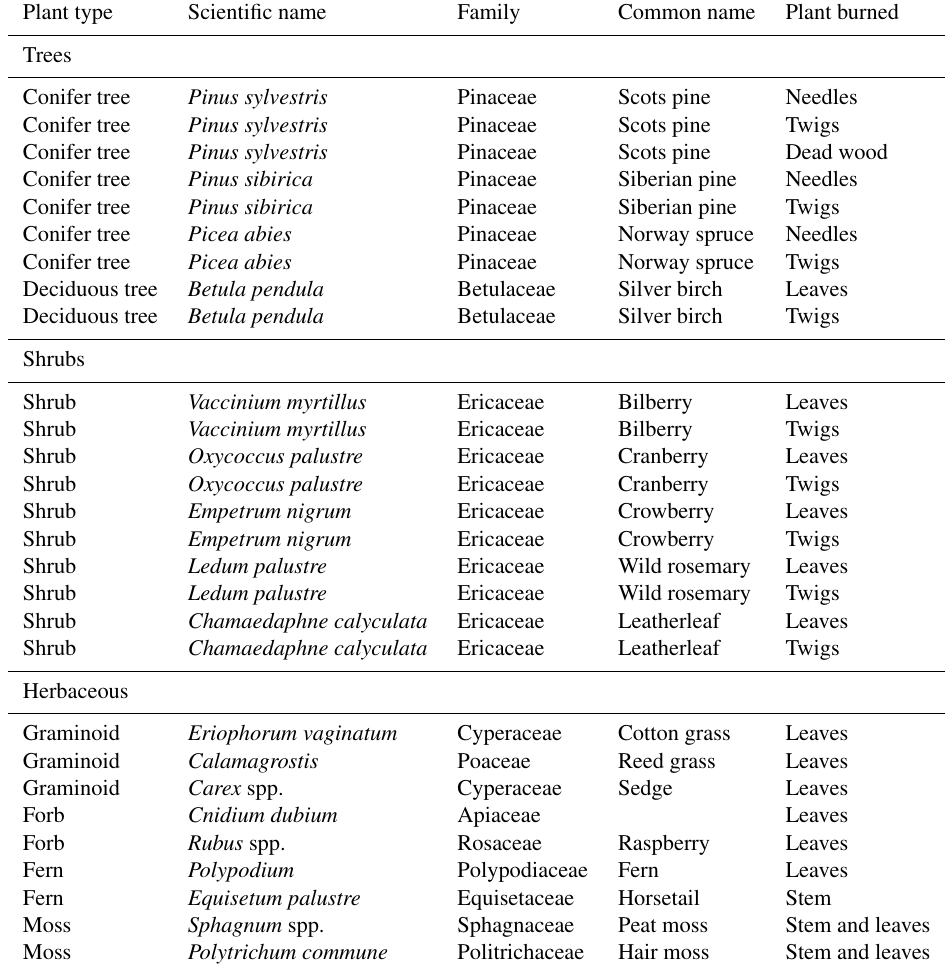
Table 1. List of plant materials burned. All plants are from Siberia except for Picea abies , which originated in Taunus, Germany. All plant material was air-dried before combustion in the muffle oven. Leaves of deciduous trees and shrubs include veins and petioles. The term “twig” was only used for woody species (i.e. deciduous and coniferous trees and shrubs), and no distinction was made between soft young